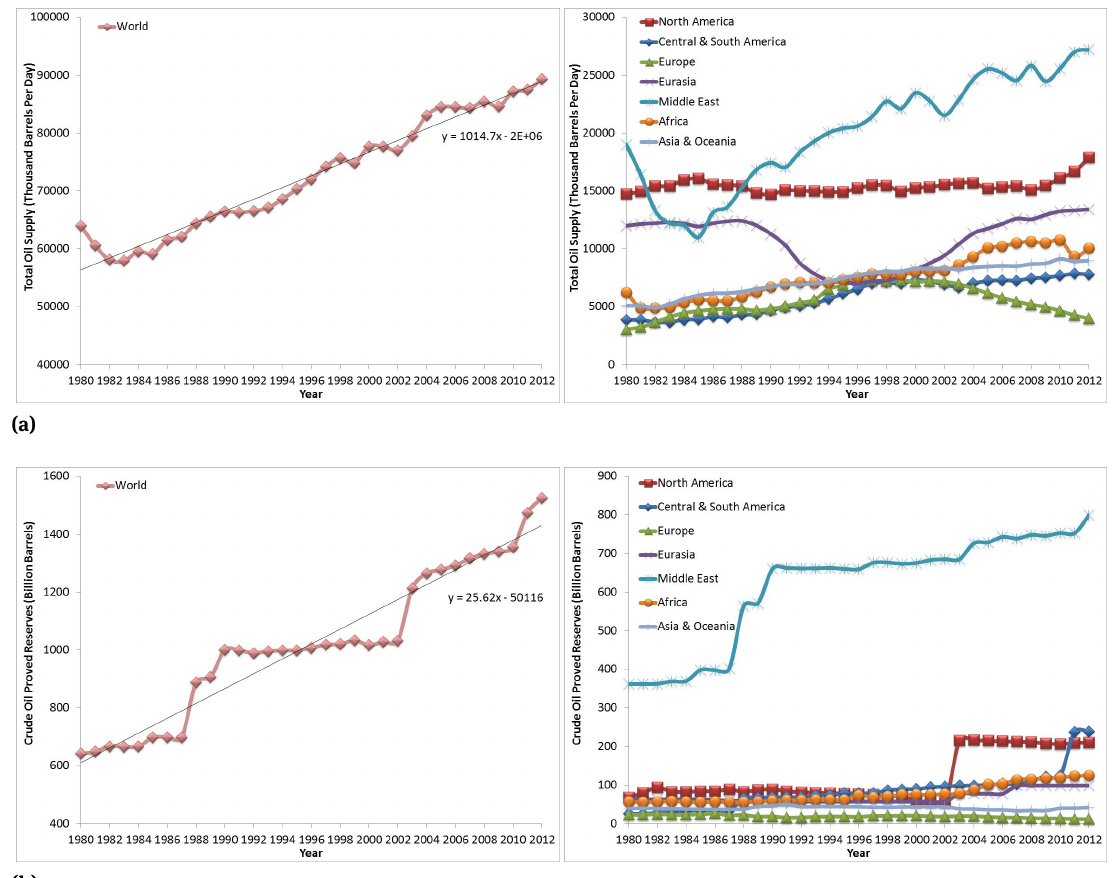
Fig. 1. (a) Oil production according to the U.S. Energy Information Administration [35].